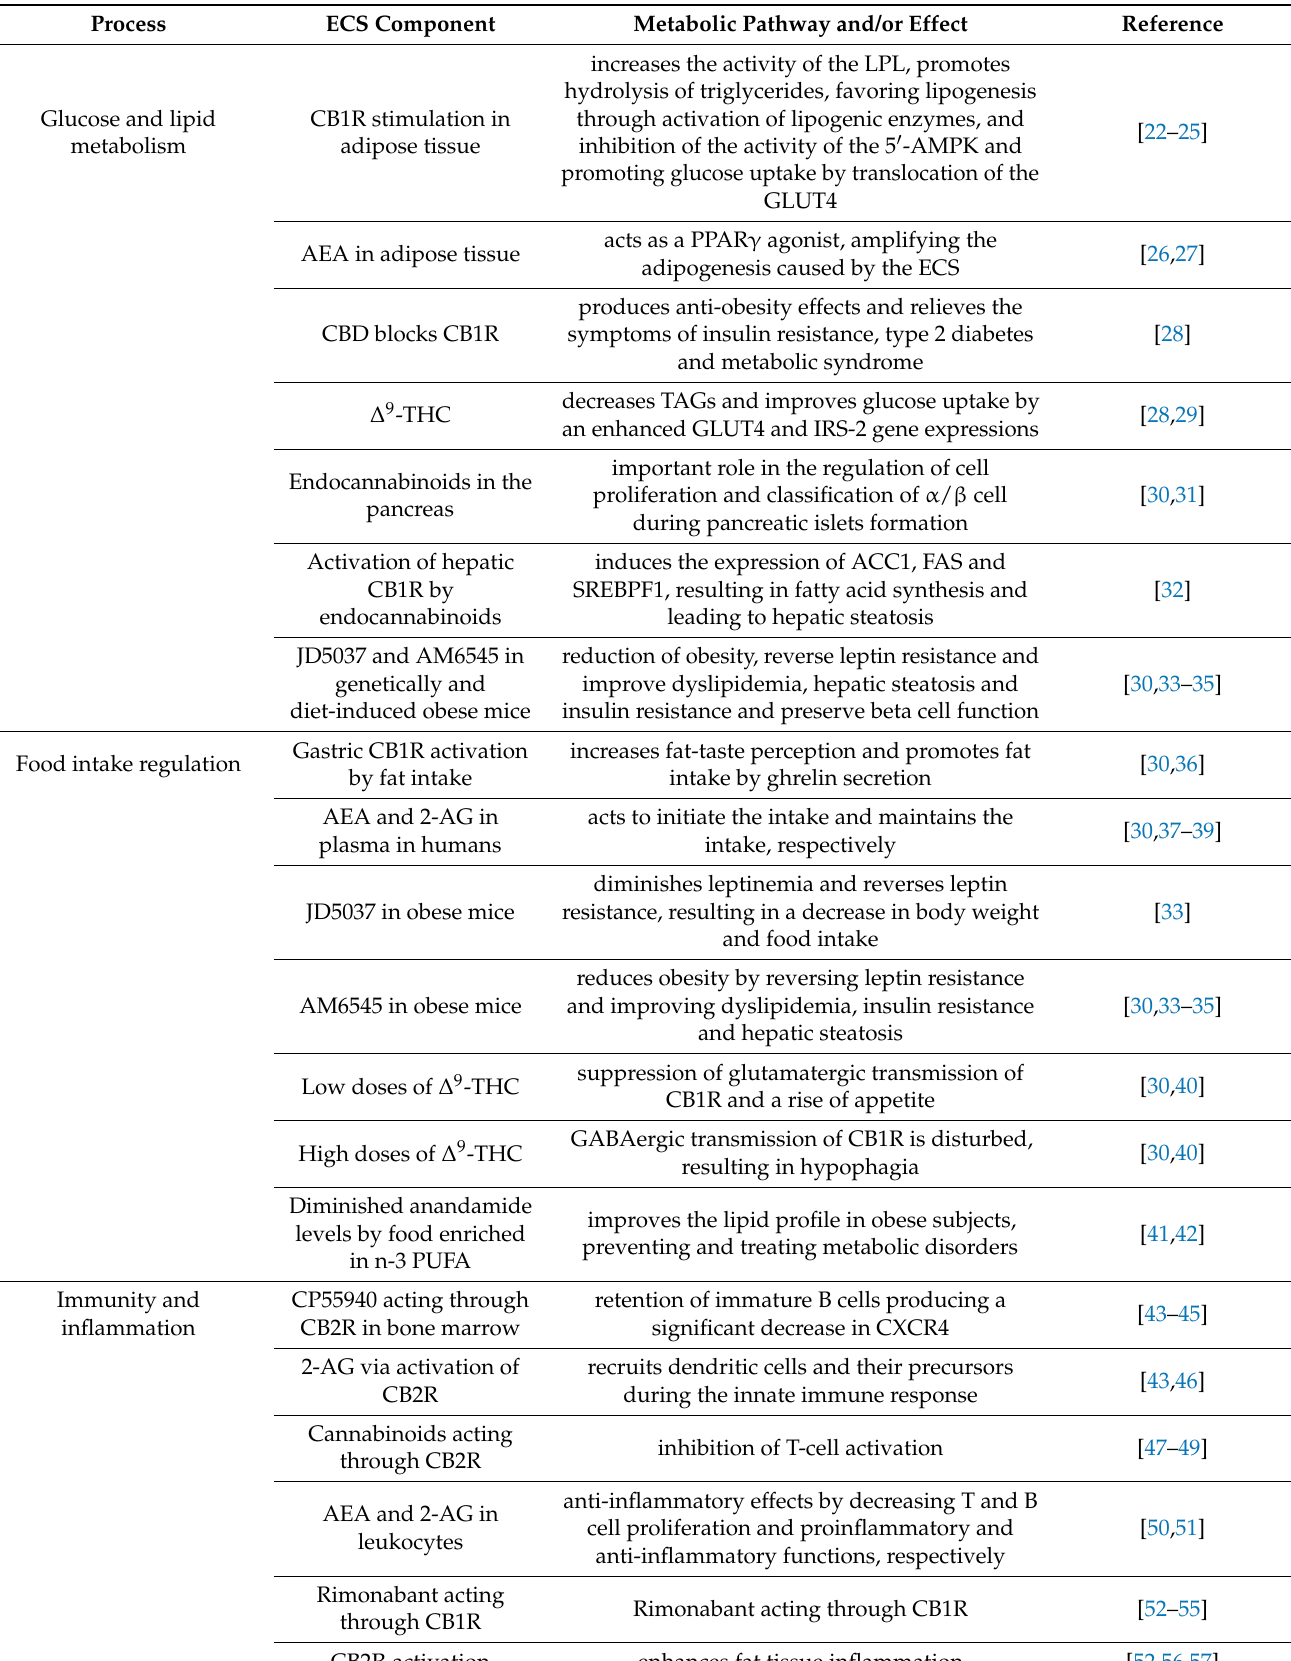
Table 1. Involvement of the ECS in various physiological and pathological